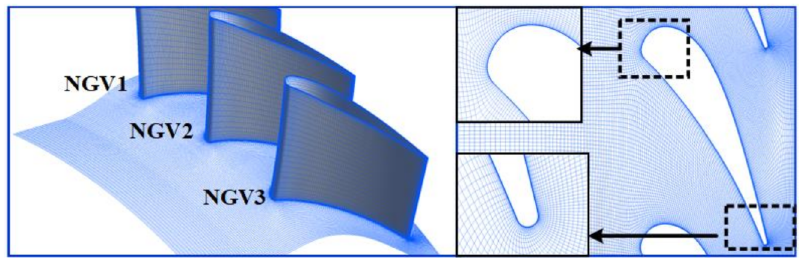
Figure 9. Computational mesh for guide vane.